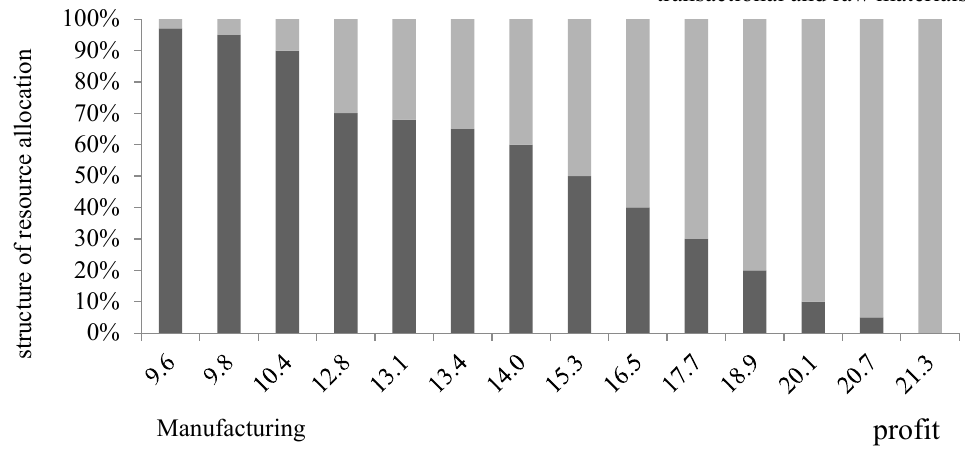
Figure 11. Resource (investment) distribution of 100 units of the value of the expected profit according to the income maximization model with two portfolio units as manufacturing and transactional and raw materials sectors in the Russian economy (profitability is taken from Figure 10) 9 (Sukharev 2020a).